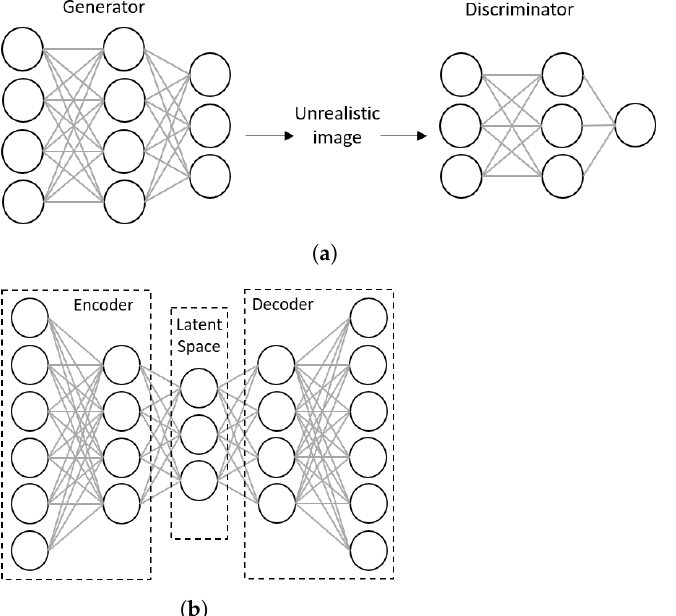
Figure 10. The basic structure of two generative neural network models. ( a ) Variational autoencoders (VAE). ( b ) generative adversarial neural networks